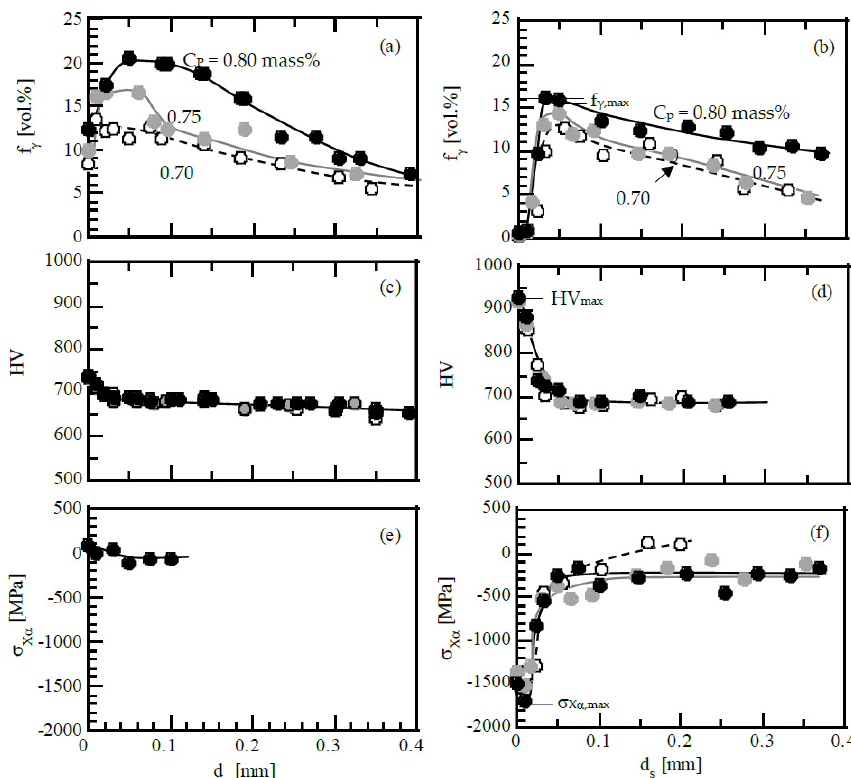
Figure 3. Variations in ( a , b ) volume fraction of retained austenite ( f γ ), ( c , d ) Vickers hardness (HV), and ( e , f ) X-ray residual stress in the α -bcc phase ( σ X α ) as a function of depth from the surface ( d s ) in TM steel subjected to vacuum ‐ carburization under carbon potentials of 0.70 mass % ( ○ ), 0.75 mass % ( ● ) and 0.80 mass % ( ● ). ( a , c , e ): After vacuum ‐ carburization, ( b , d , f ): After vacuum ‐ carburization and fine ‐ particle peening.